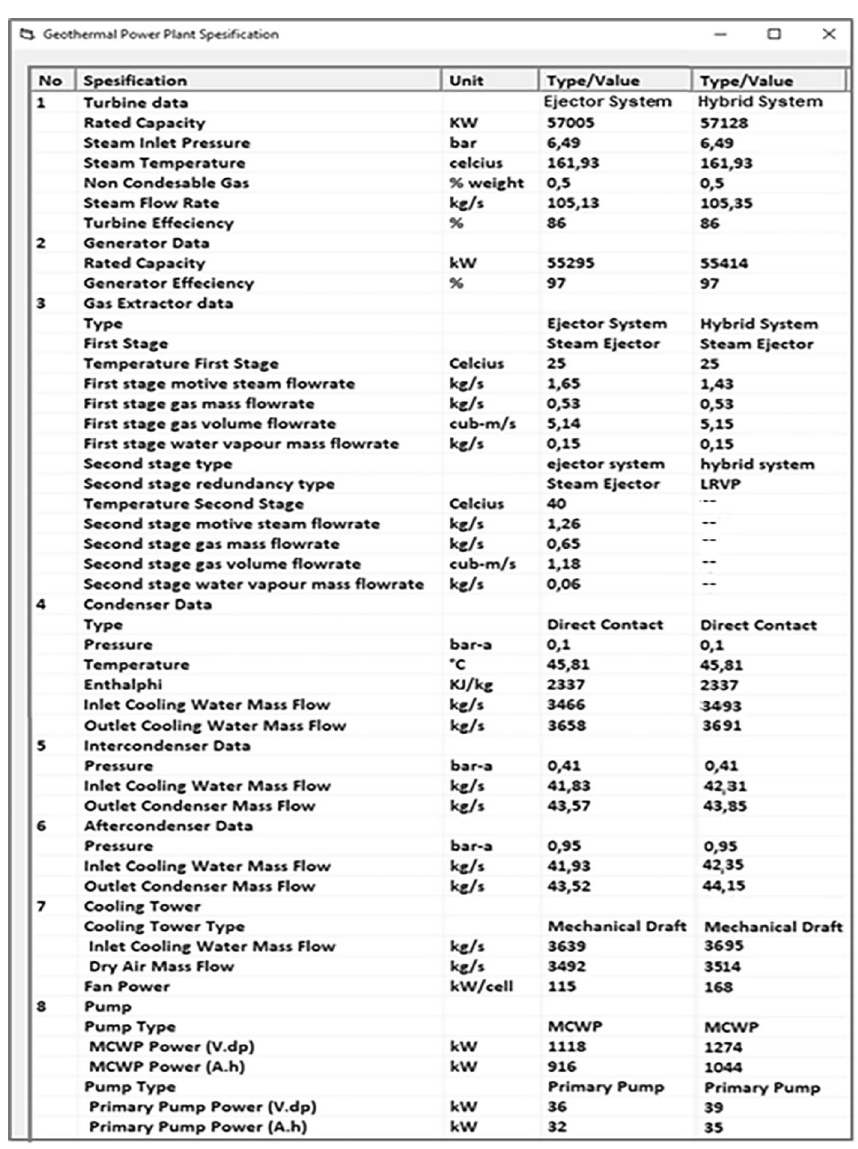
Fig. 14 Output of specification Kamojang GPP Units 2 and